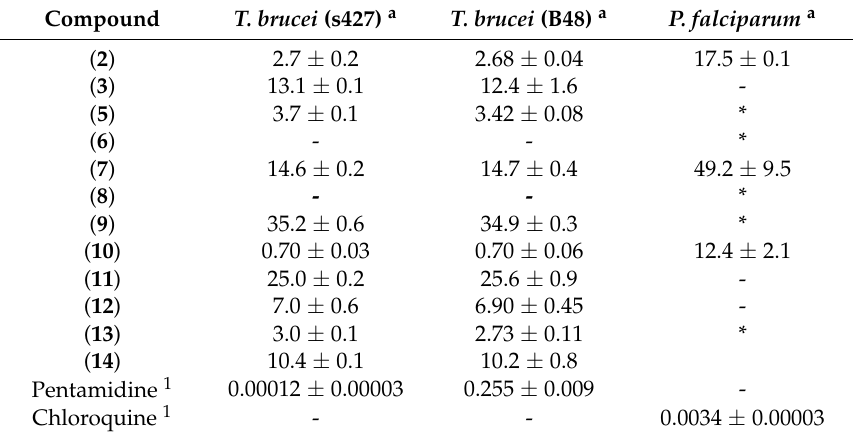
Table 4. EC 50 values ( µ g/mL) of the antiprotozoal activities of compounds isolated from Libyan propolis tested against T. brucei and P. falciparum